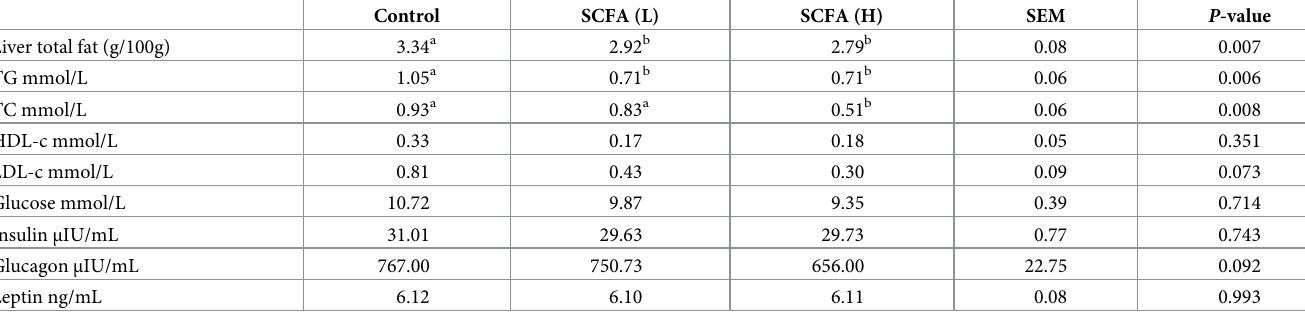
Table 5. Effects of SCFAs on the liver lipids and metabolites over the experimental period of weaned